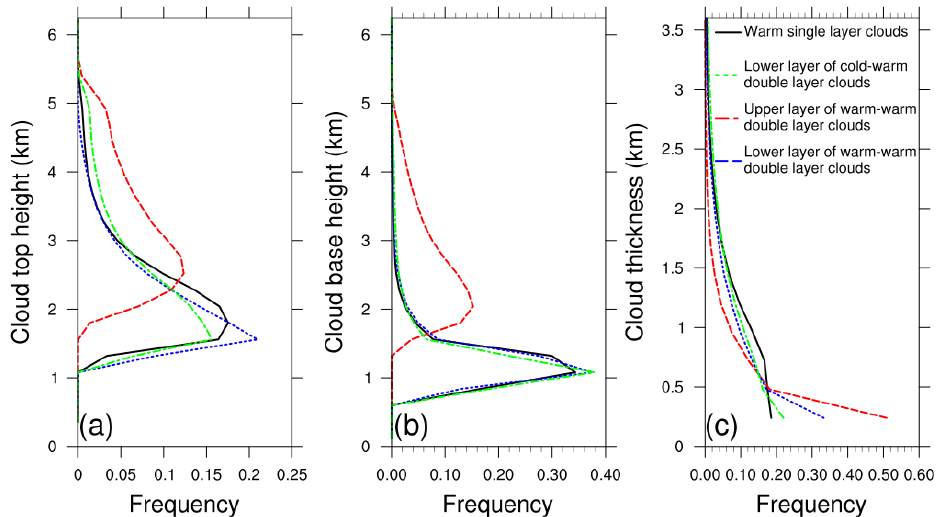
Figure 5. Frequency distribution of cloud top height ( a ), base height ( b ), and geometric thickness ( c ) of the four types of warm cloud layers.